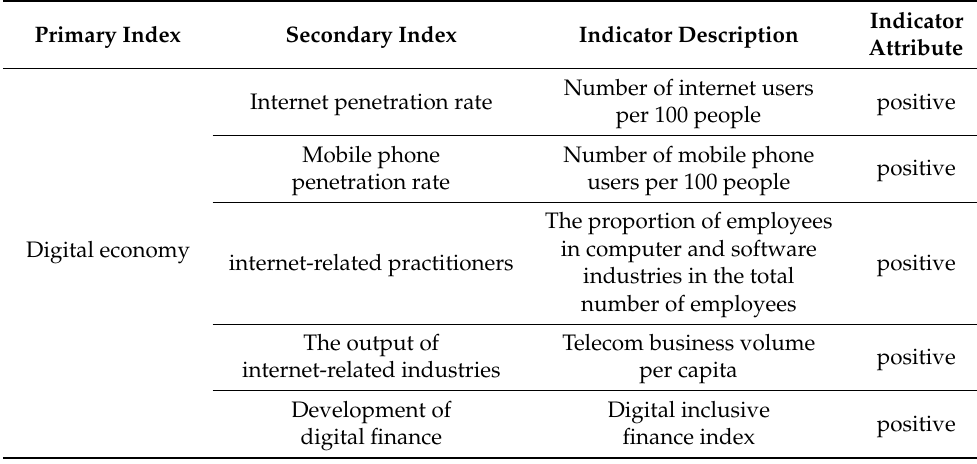
Table 2. The evaluation index system of urban digital